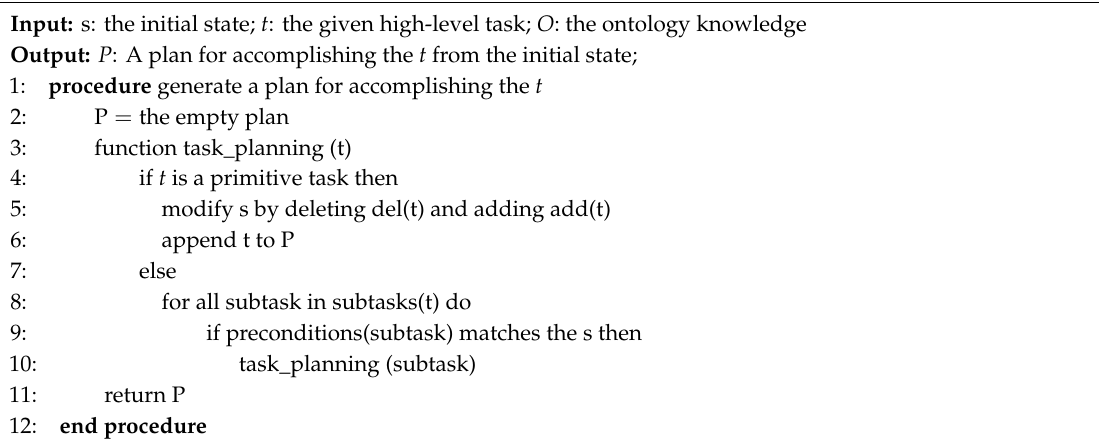
Algorithm 1 Task Planning Algorithm Based on Robot Task Planning Ontology (RTPO)